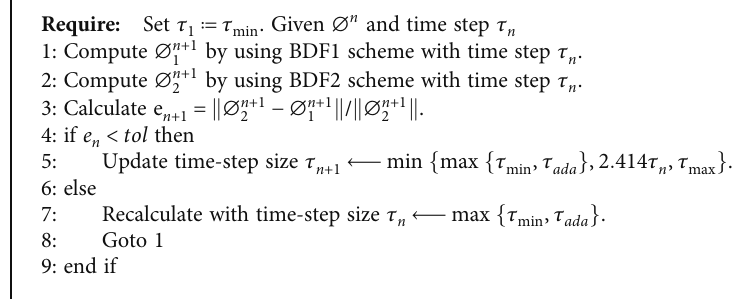
Algorithm 1: Adaptive time-stepping strategy.